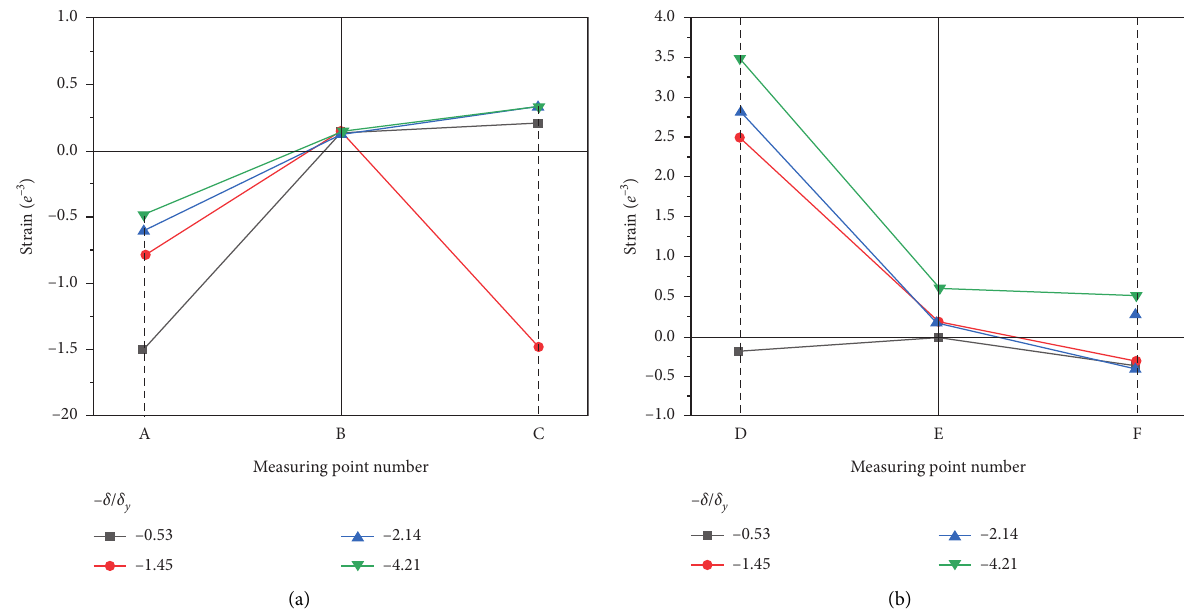
Figure 13: Rebar strain of grouted sleeve. (a) Strain development of sleeve joints at the bottom of beam ends in negative moment zone. (b) Strain development of sleeve joints at the bottom of beam ends in positive moment zone of beams.